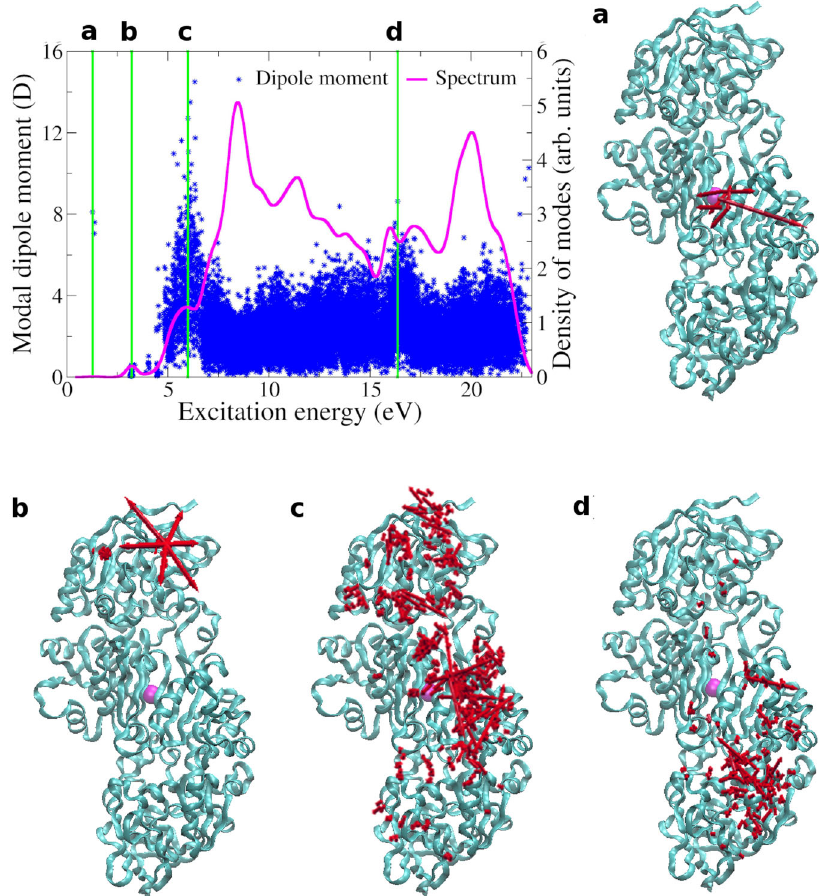
Fig. 4 Analysis of MBD exciton modes for the human protein 1MC5. The MBD excitation spectrum is reported together with the overall dipole moment (absolute value) characterzing each excitation mode. Non-covalent optical-vdW forces (illustrated as red arrows) are reported for select excitation modes ( a – d ), indicated in the spectrum by green vertical lines. The position of the potassium site close to the protein center is indicated with a magenta sphere. Relatively localized dynamics are associated to low-frequency excitations, whereas remarkably collective forces are found at higher